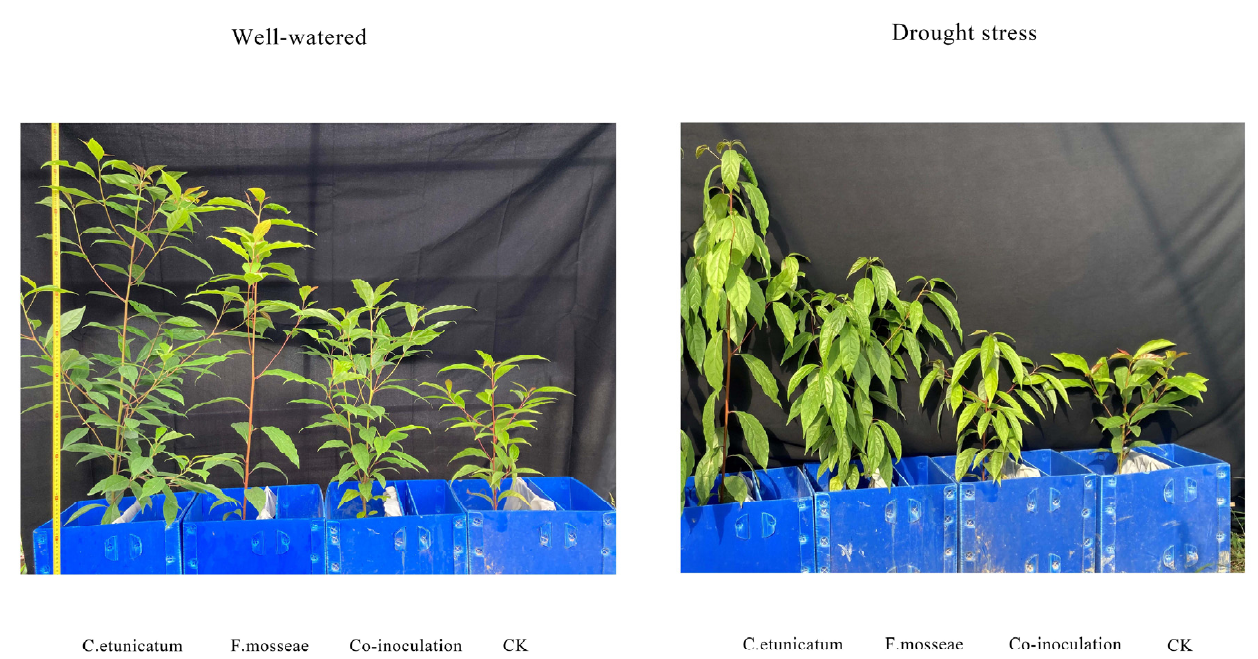
Figure 3. Effect of arbuscular mycorrhizal fungus (AMF) on the Plant height of C. migao seedlings. CK, non-AMF control; C. etunicatum , plants inoculated with C. etunicatum ; F. mosseae, plants inoculated with F. mosseae; Co-inoculation, plants inoculated with F. mosseae and C. etunicatum .